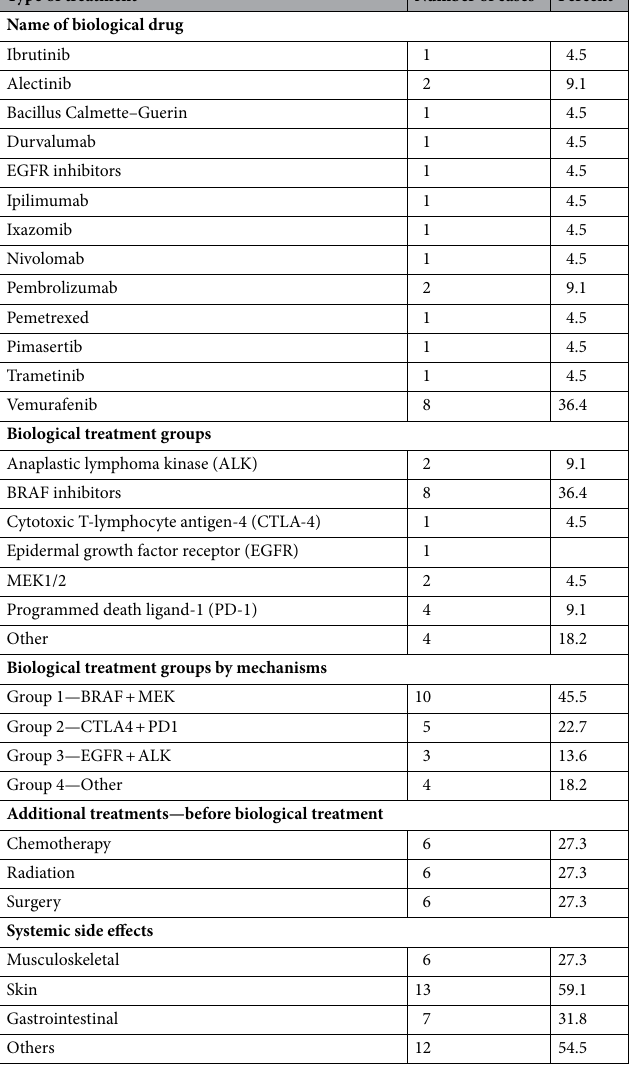
Table 1. Biological therapies.